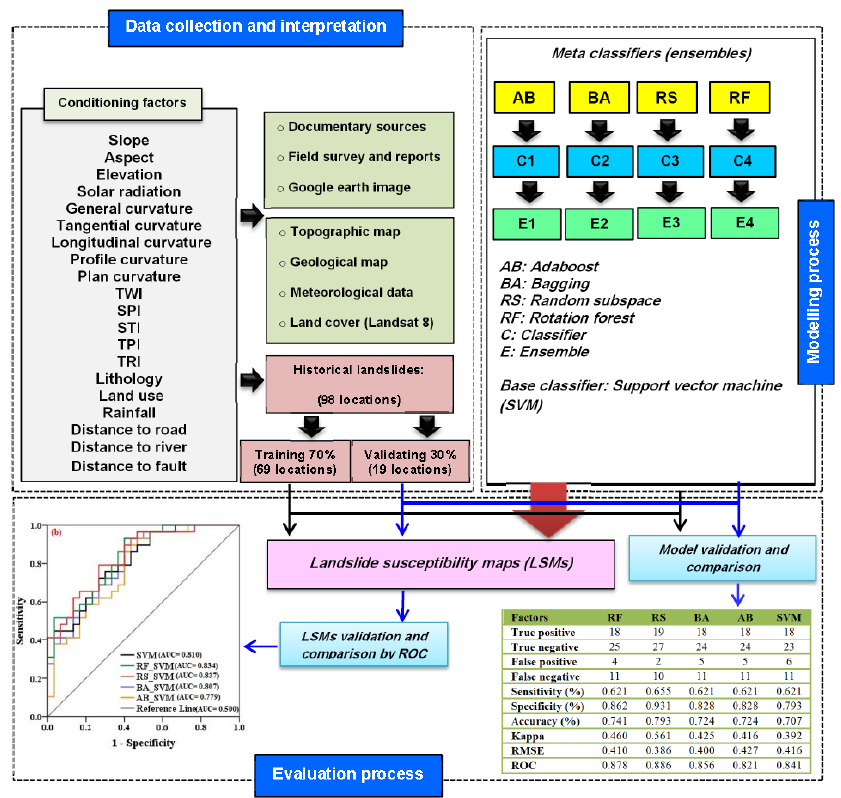
Figure 5. Flowchart of methodology used in this study.